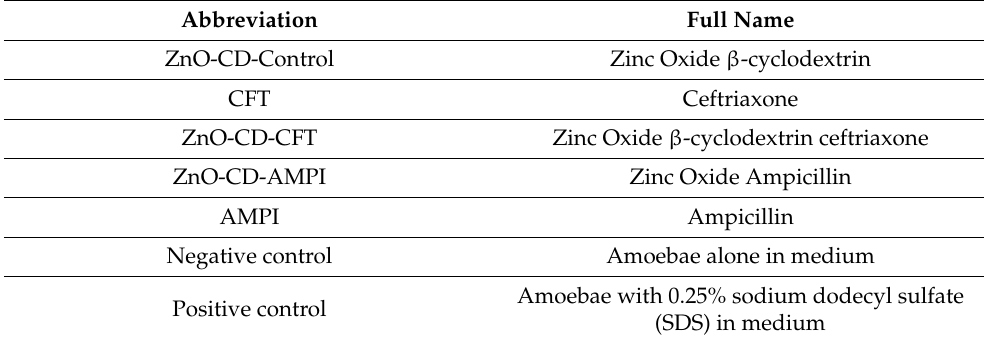
Table 1. This table outlines the nanocarriers and drugs used in this study with their